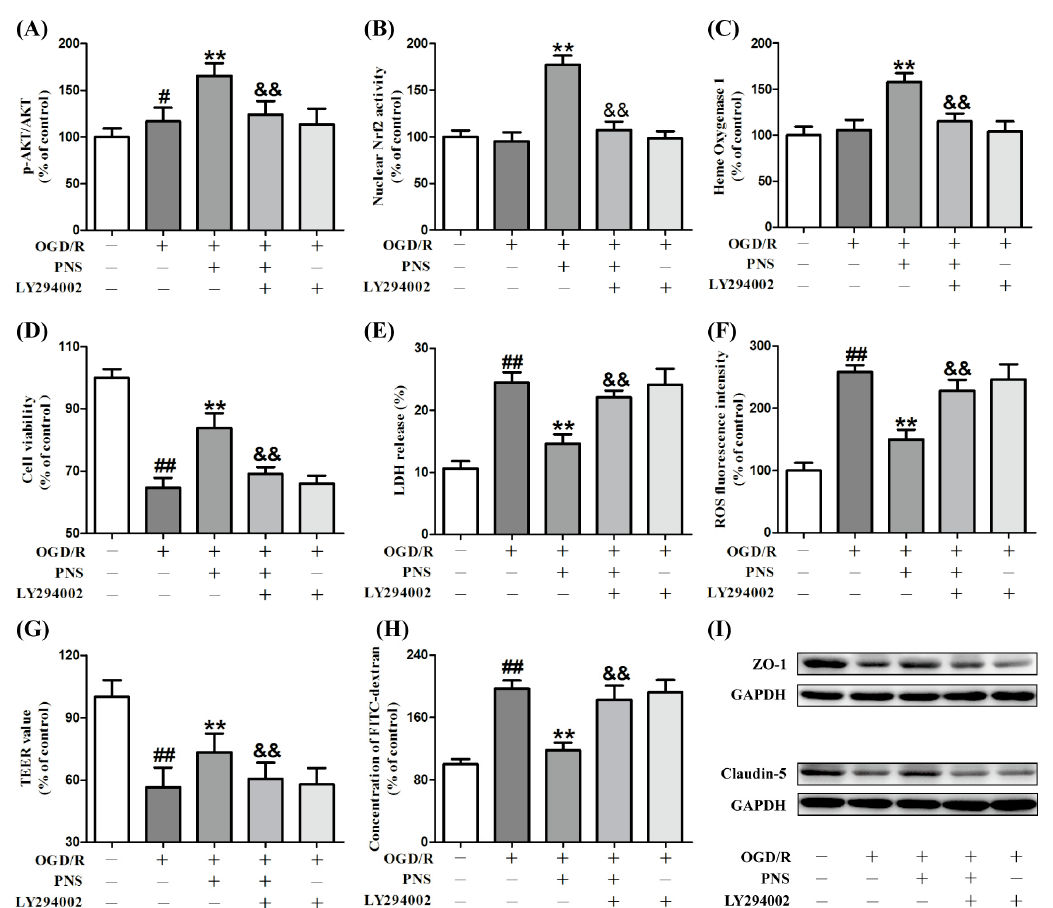
Figure 6. Effects of PNS on bEnd.3 cells with OGD/R injury were inhibited by LY294002. Upregulation of p-Akt/Akt ratio ( A ), nuclear Nrf2 activity ( B ) and HO-1 expression ( C ) were almost inhibited by LY294002. The protective effects of PNS on cell viability ( D ) and cytotoxicity ( E ) were almost inhibited by LY294002. ( F ) The inhibitory effect of PNS on ROS production was almost inhibited by LY294002. The protective effects of PNS on barrier integrity ( G , H ) and tight junction disruption ( I ) were almost inhibited by LY294002. LY294002 had no significant effect on OGD/R- treated cells compared to the OGD/R group. Data are expressed as mean ± SD (N > 3). ## p < 0.01 vs. Control, ** p < 0.01 vs. Model, && p < 0.01 vs. PNS treatment group.